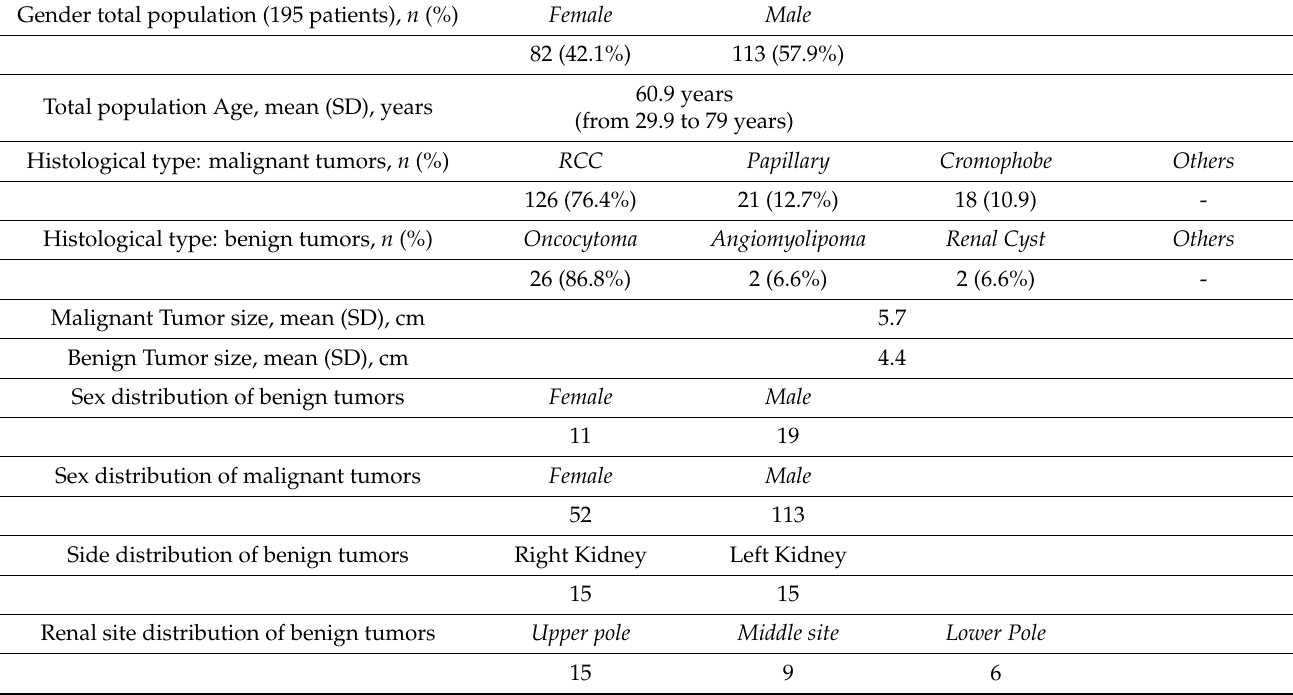
Table 1. Demographics and pathological features of all renal